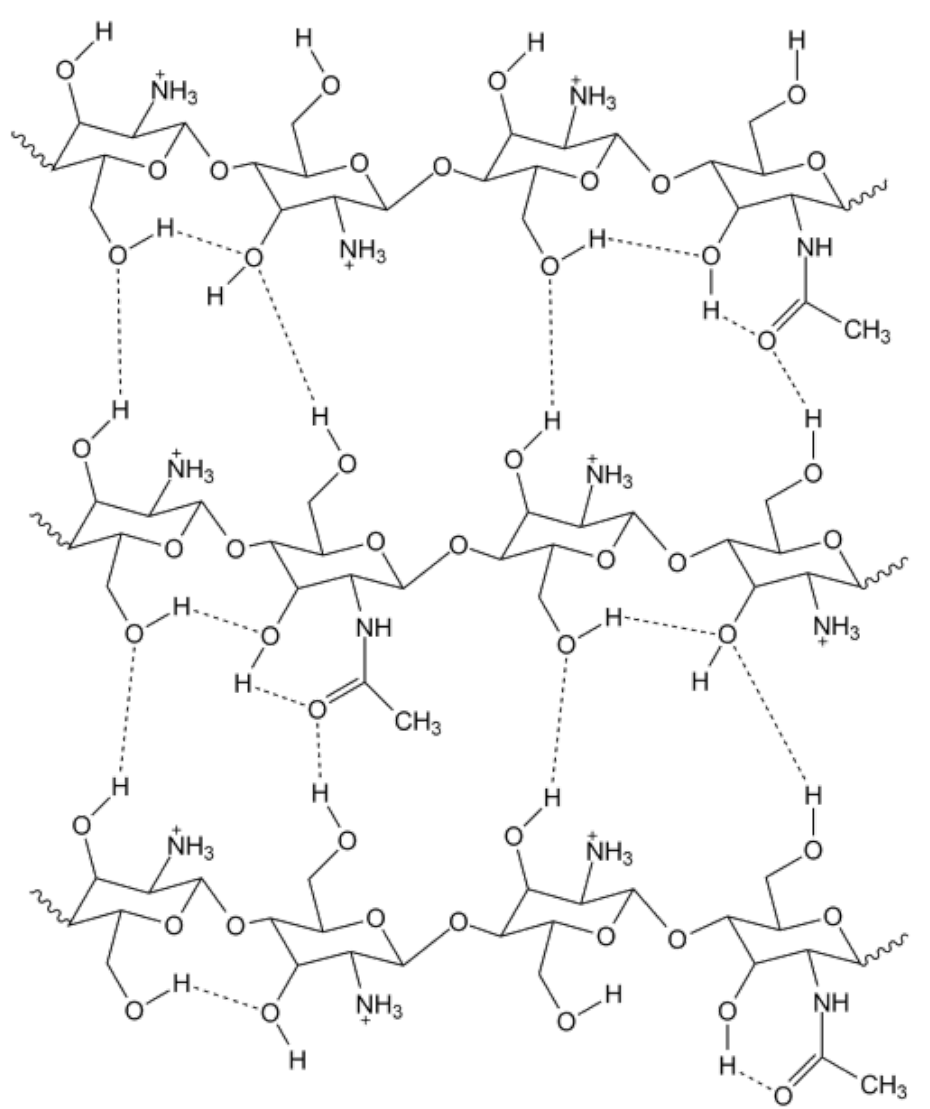
Figure 1. The intramolecular and intermolecular hydrogen bonding that occurs in chitosan dissolved in acidic media, resulting in the formation of a non-covalently bound network.